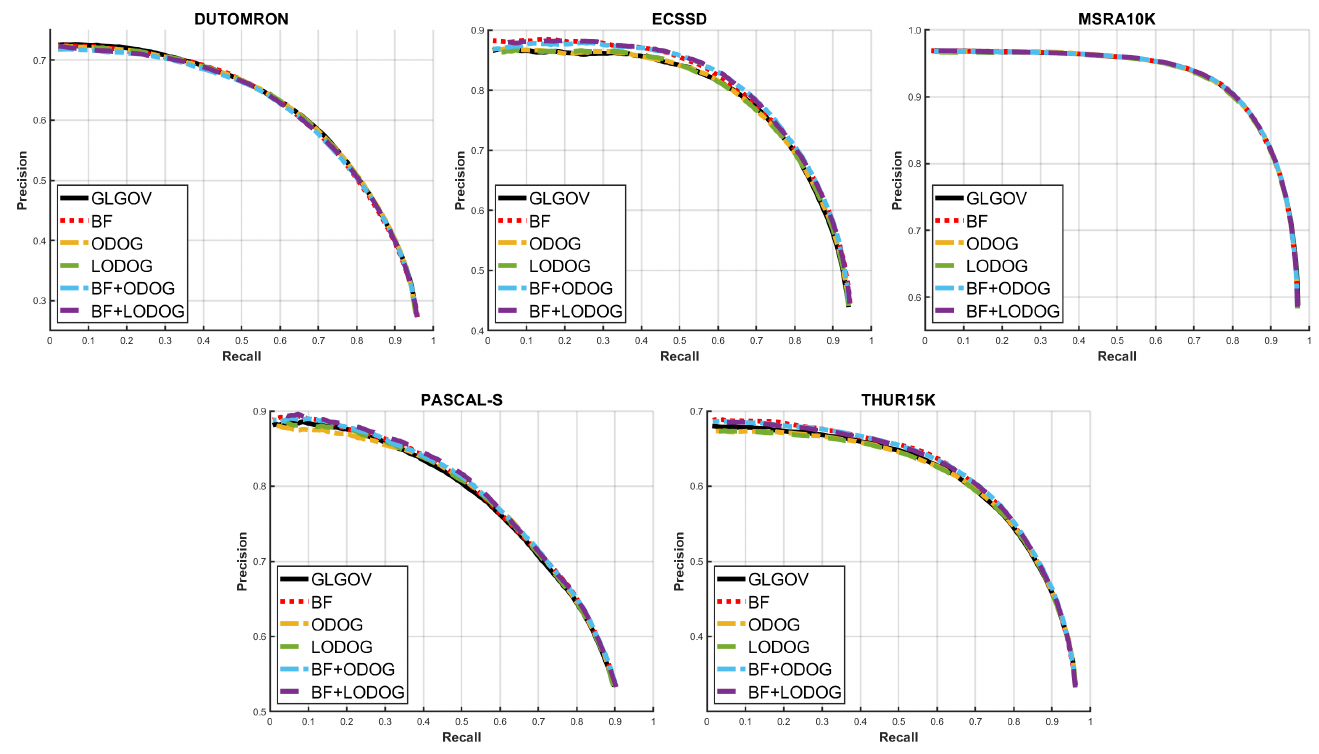
Figure 15. PR curve of GLGOV.